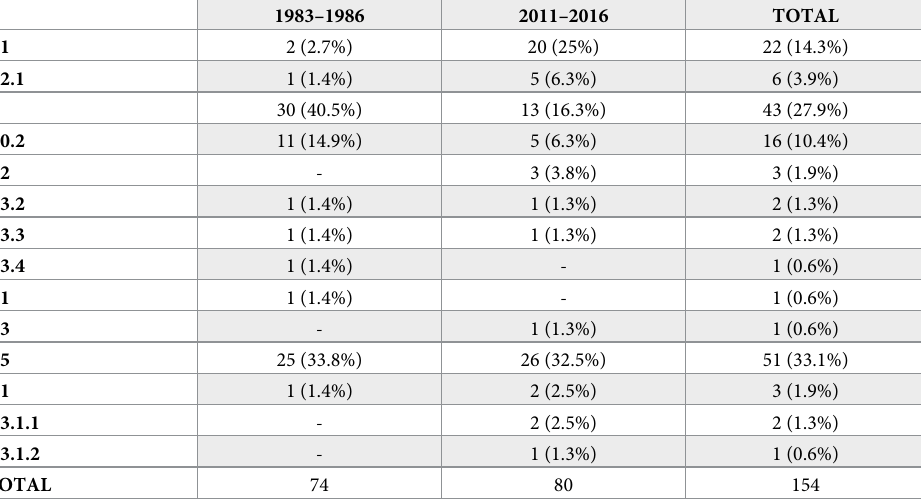
Table 1. S. Typhi genotypes detected in isolates from acute clinical cases in Santiago, Chile during the hyperen- demic 1980s versus the nonendemic